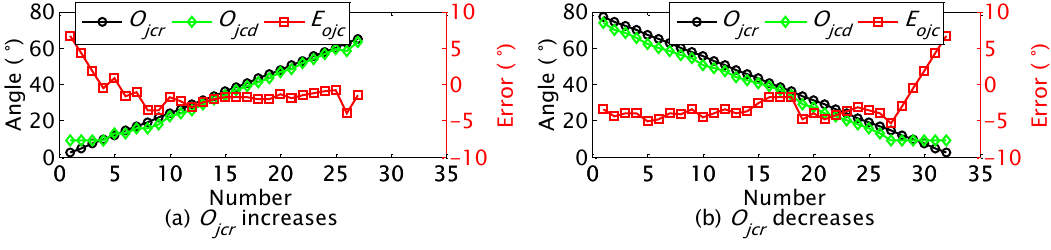
Figure 19. Results of dynamic cooperation for detection of O jc